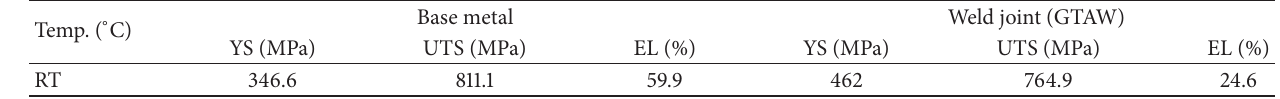
Table 2: The tensile mechanical properties of Alloy 617.